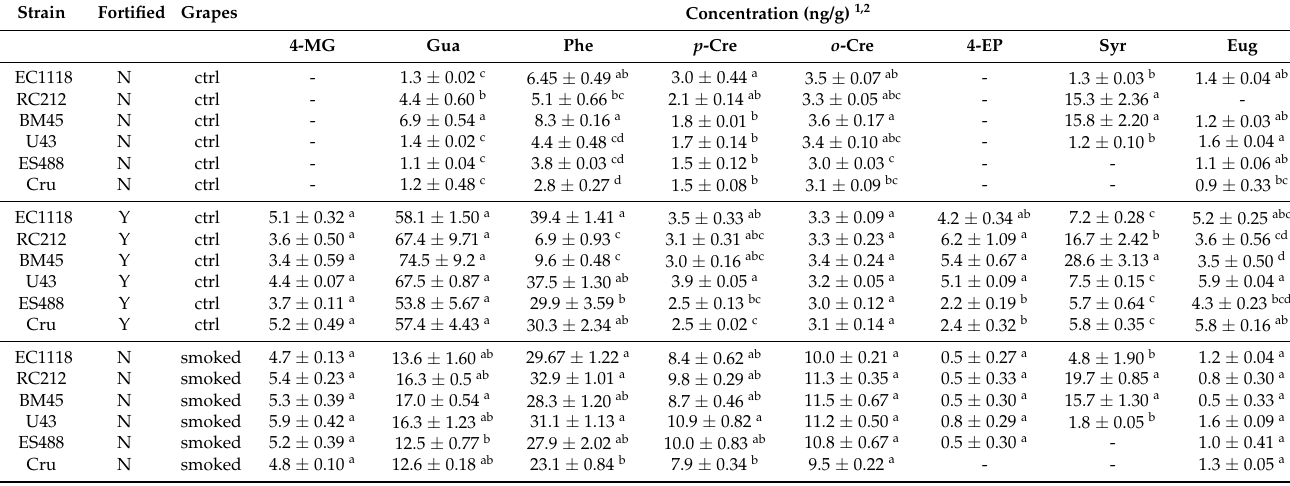
Figure 3. Concentrations of volatile phenols (VPs) in wines produced by different yeast strains from smoke-exposed or control Pinot Noir grapes with and without fortification with VP-monoglucosides. All VP-monoglucosides were added to grape samples at a concentration of 200 ng/g. The lower, gray histograms depict the concentration of ethanol measured at the end of primary fermentation. Table 3. Free VPs quantitated in Pinot Noir wines fermented with six commercial strains of S. cerevisiae . Treatment groups included grape musts that were unfortified/fortified with VP-monoglucosides (200 ng/g), as well as musts that were